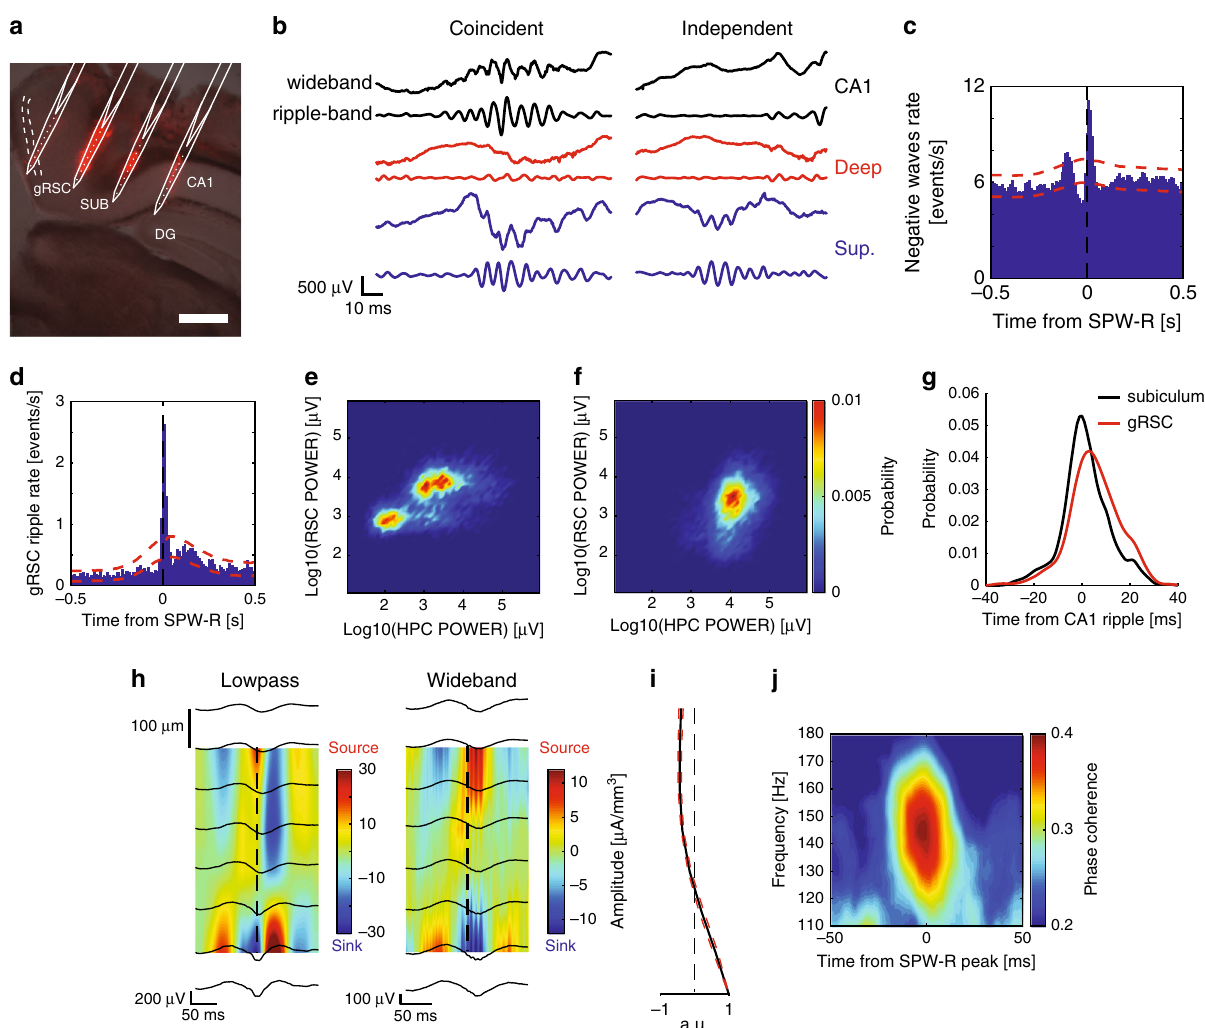
Fig. 2 gRSC activity is tightly coupled to hippocampal SPW-Rs. a Example histological veri fi cation of probe location (DiI, red). Relevant areas are labeled; L2/3 is marked by dashed lines. Scale bar, 500 µ m. b Two examples of gRSC ripples showing traces of wide-band (top trace) and ripple band (bottom trace) fi ltered activity from CA1 area (top, black), deep layers gRSC (middle, red) and super fi cial layers gRSC (bottom, blue). c Average cross-correlogram between SPW-R events and negative waves in super fi cial gRSC ( n = 8 sessions from four animals; 3409 SPW-Rs, 72,422 negative waves). Red lines, 95% con fi dence intervals. d Average cross-correlogram between CA1 (reference) and gRSC ripples ( n = 18 sessions from six animals; 22,694 CA1 SPW-Rs, 8501 gRSC ripples). e Density distribution of peak ripple band power correlations between CA1 and super fi cial gRSC recording sites for gRSC ripples (least- square slope = 0.40; ρ = 0.60; p < 10 − 10 , two-sided Student ’ s t -test). f Same as ( e ) but for CA1 ripples (least-square slope = 0.42; ρ = 0.31; p < 10 − 10 ). g Probability distribution of subicular and gRSC ripple peak power lags relative to CA1 peak power ( n = 4 sessions from two mice where simultaneous targeting of CA1, subiculum and super fi cial gRSC was histologically con fi rmed; median lag of subicular ripples: 0.80 ± 0.32 ms; gRSC ripples: 4.76 ± 0.34 ms; p = 1.5×10 -17 , two-sided signed rank test). h CSD analysis from two example sessions showing low-passed fi ltered (left) and broad-band (right) versions centered around CA1 SPW-R peak (dashed line; 821 and 430 events, respectively). i ICA (mean ± s.e.m) decomposition of voltage traces from the gRSC centered around CA1 SPW-R showing an increase in voltage loadings in super fi cial layers ( n = 8 sessions from seven animals; p = 0.000155, two- sided rank sum test between fi rst IC loads of top and bottom channels). j Wavelet phase coherogram between CA1 and super fi cial gRSC LFP centered around CA1 SPW-R detection (7150 events from seven